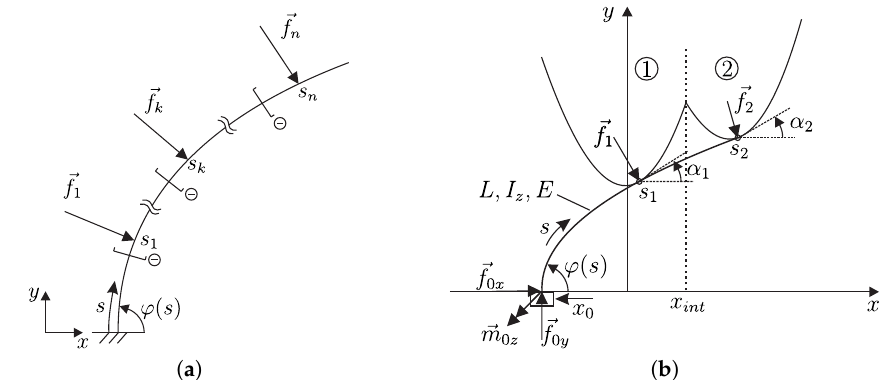
Figure 1. Mechanical model of a rod: ( a ) with a finite number of acting forces; ( b ) in contact with a piecewise-defined object contour function according to